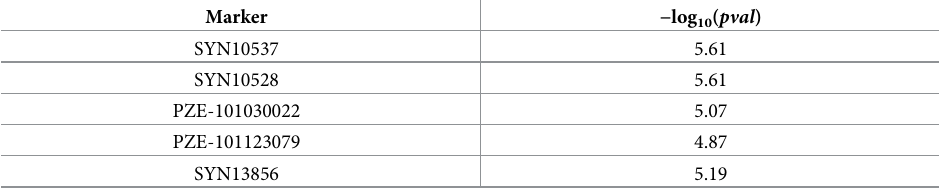
List of significant markers at a nominal level of 5% (Gao correction for multiple testing).